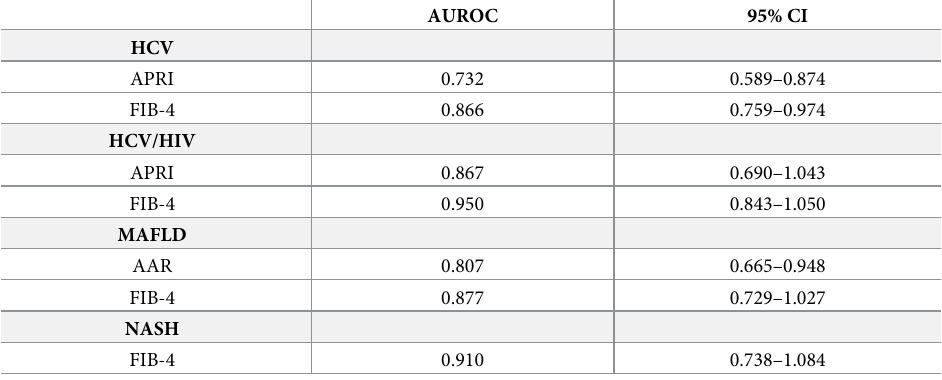
Table 4. AAR, APRI and FIB-4 AUROC to determine significant fibrosis.